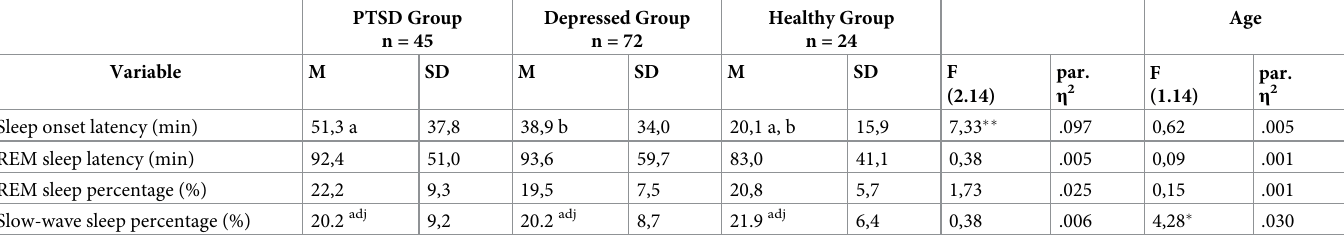
Table 1. Differences between the three study groups in terms of sleep physiological variables (sleep onset latency, REM sleep latency, slow-wave sleep percentage of sleep period time, REM sleep percentage of sleep period time).